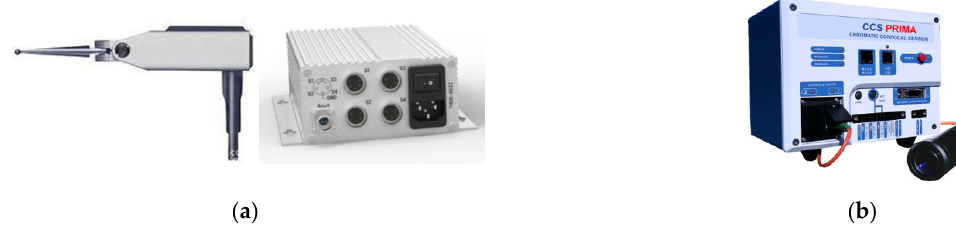
Figure 10. The sensors used in the experiment. ( a ) TESA GT31 displacement sensor; ( b ) STIL spectral confocal